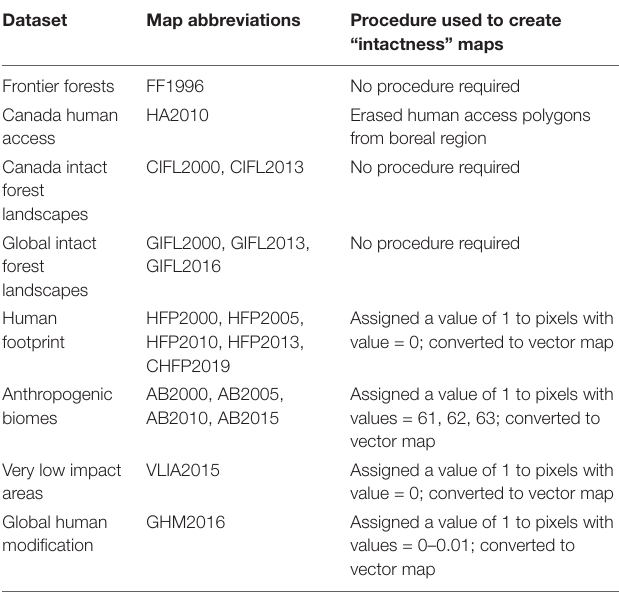
TABLE 2 | GIS procedures used to derive “intactness” maps. Map abbreviations are used in the text to refer to the names of the intactness and reclassified human influence